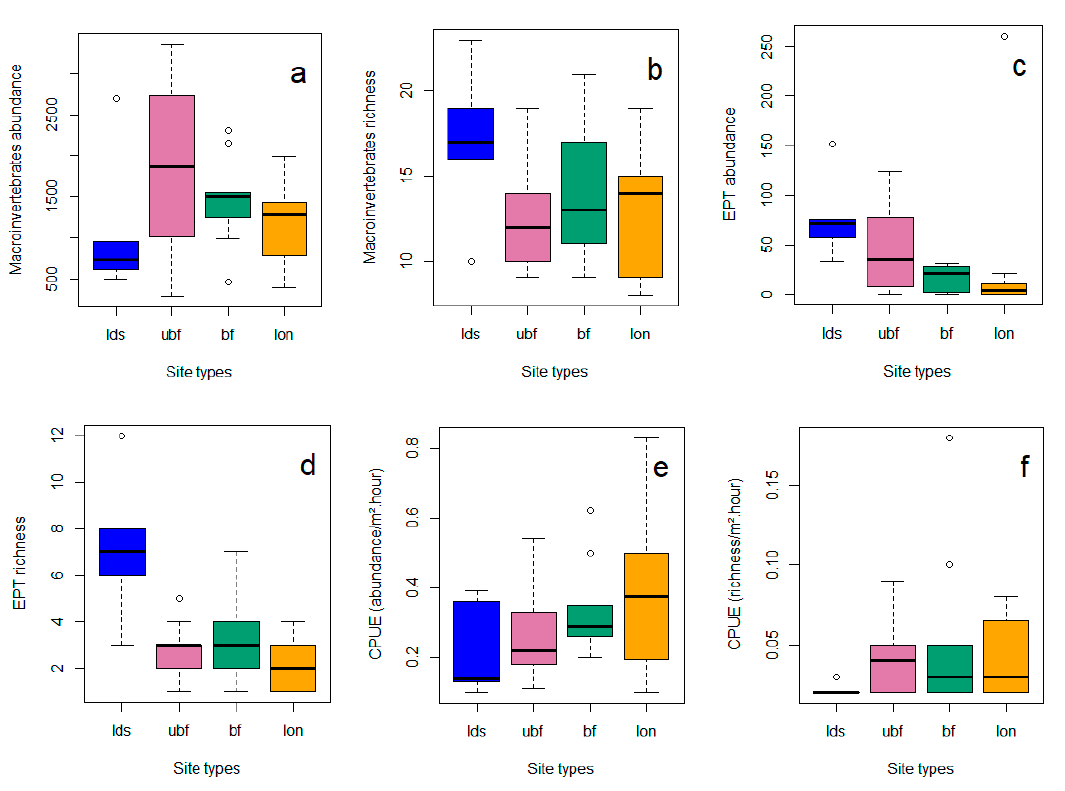
Figure 2. Boxplots of stream macroinvertebrate abundance ( a ), stream macroinvertebrate richness ( b ), Ephemeroptera, Plecoptera and Trichoptera (EPT) abundance ( c ), EPT richness ( d ), catch per unit effort (CPUE)—terrestrial invertebrate abundance m − 2 h − 1 ( e ) and CPUE—terrestrial invertebrate richness m − 2 h − 1 ( f ), with respect to the site types lds (least-disturbed sites), ubf (unbuffered), bf (buffered) and lon (downstream).